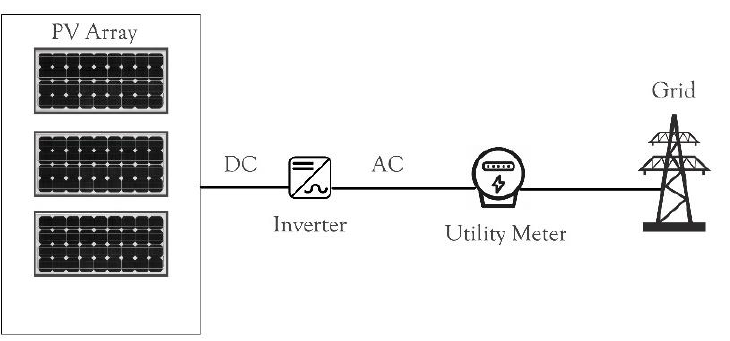
Figure 1. Grid-connected PV system configuration.